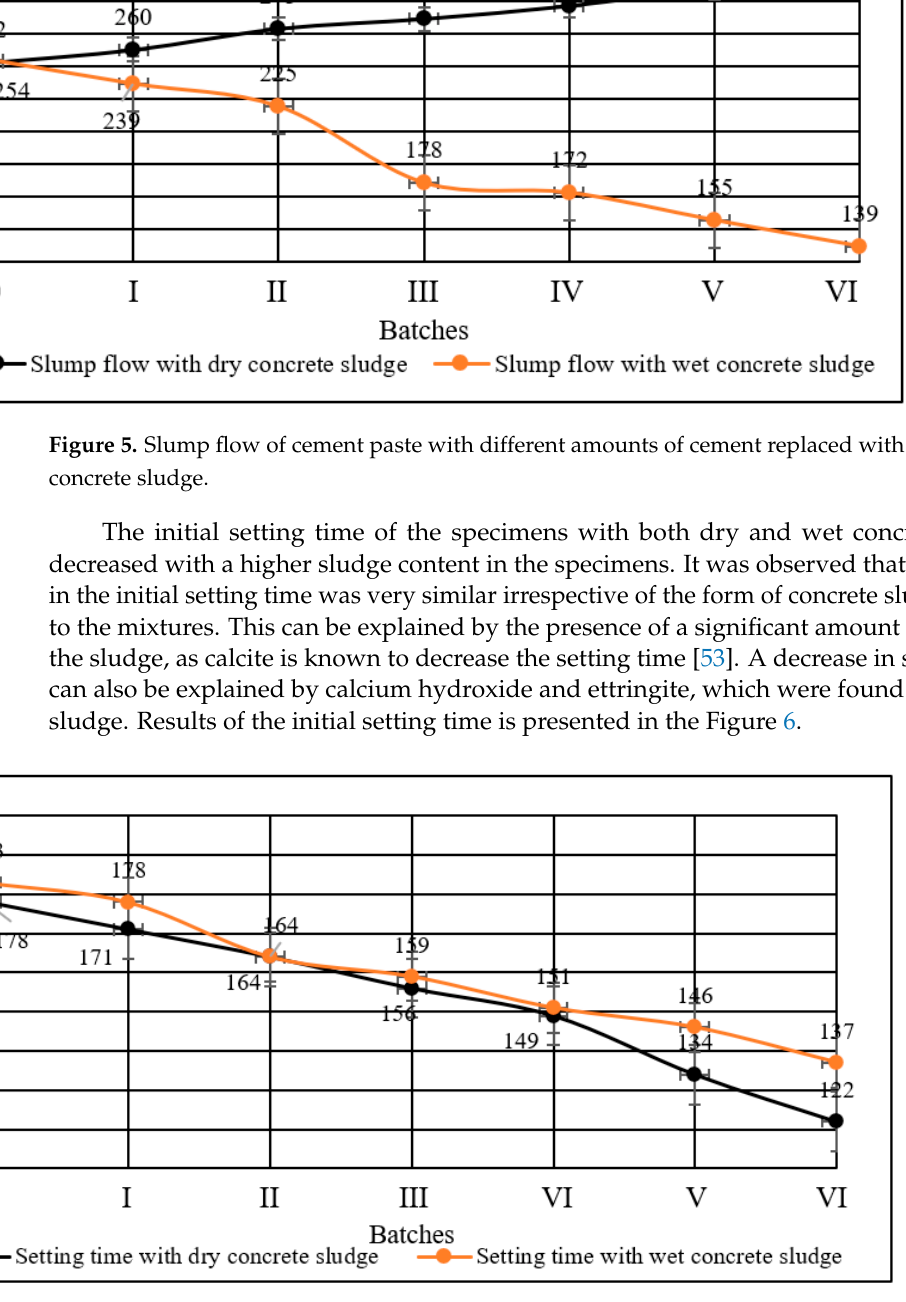
Figure 6. Initial s etting time of cement paste with different amounts of cement replaced with wet and dry concrete